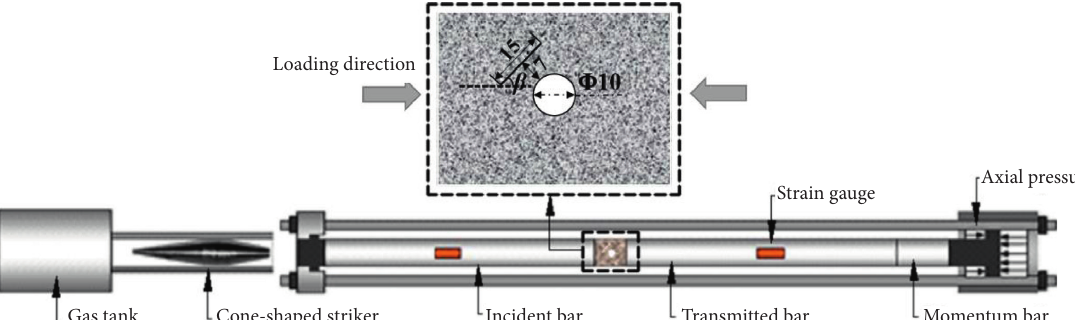
Figure 1: SHPB system modified from reference [43] for coupled axial static and dynamic loading and the geometry of the specimen.